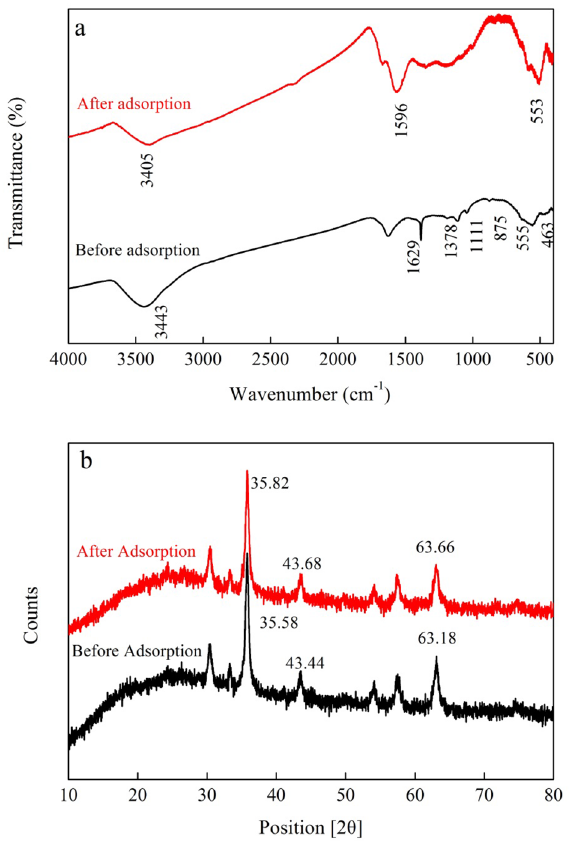
Figure 6. FTIR spectrum ( a ) and XRD spectrum ( b ) before and after the adsorption of Cr(VI) by